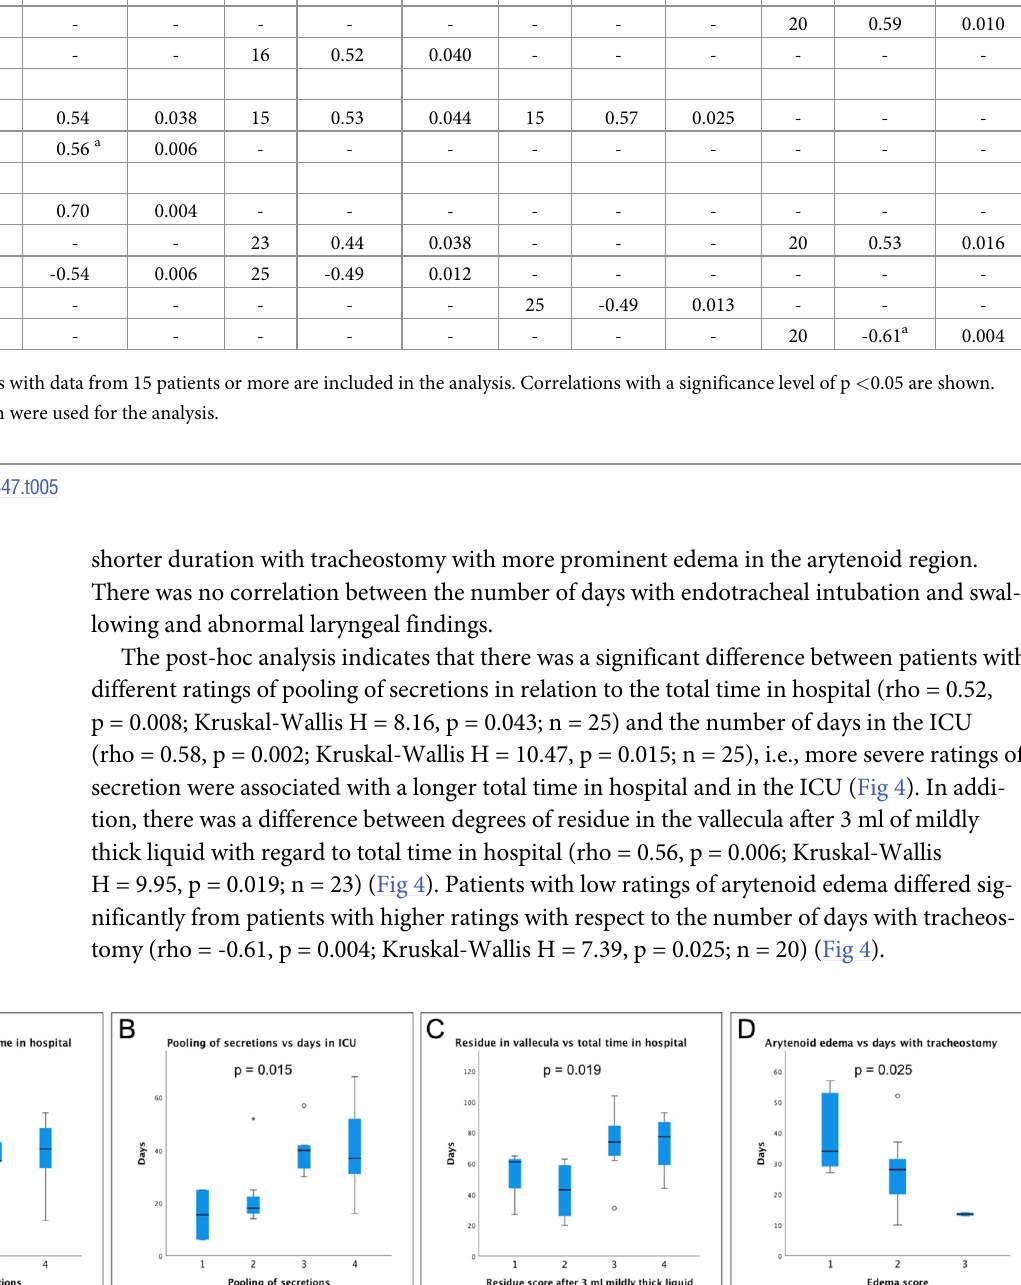
Fig 4. Box plots of FEES variables with a significance of p < 0.05 on post-hoc analysis. (A,B) Pooling of secretions; (C) Residue in the vallecula and (D) Arytenoid edema versus total time in hospital (A, C), number of days in ICU (B), and days with tracheostomy (D). Variables with a significance of p < 0.05 on post-hoc analysis using the Kruskal-Wallis test are included. Median, 25th and 75th percentiles are shown.